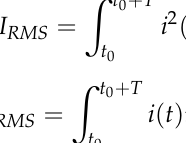
Table 1. Tested appliances.